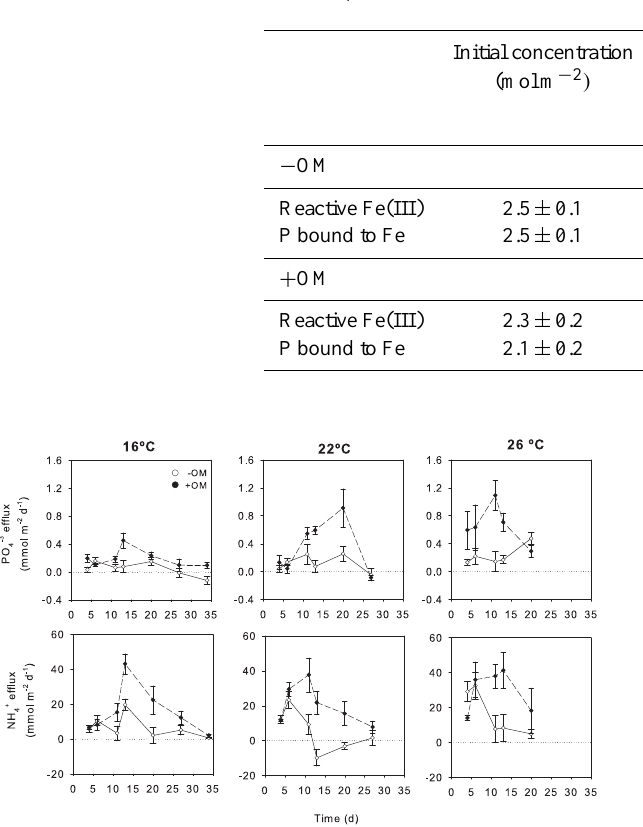
Table 2. Depth-integrated (0–16cm) pools of reactive Fe(III) and P bound to reactive Fe (mean ± SE) for initial cores ( n = 3) and final cores ( n = 6). See notes below Table 1 for explanation of treatments.